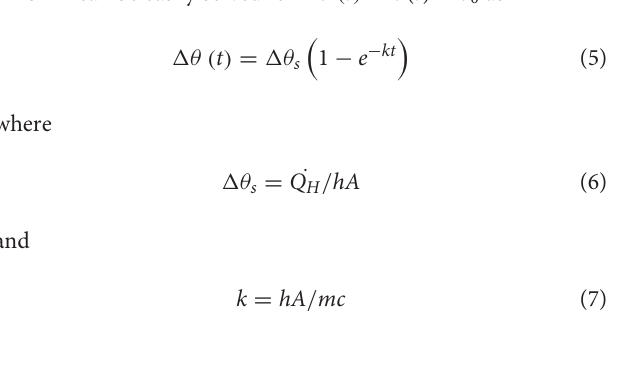
This DE can be easily solved for 1θ ( t ) = θ ( t ) − θ 0 as